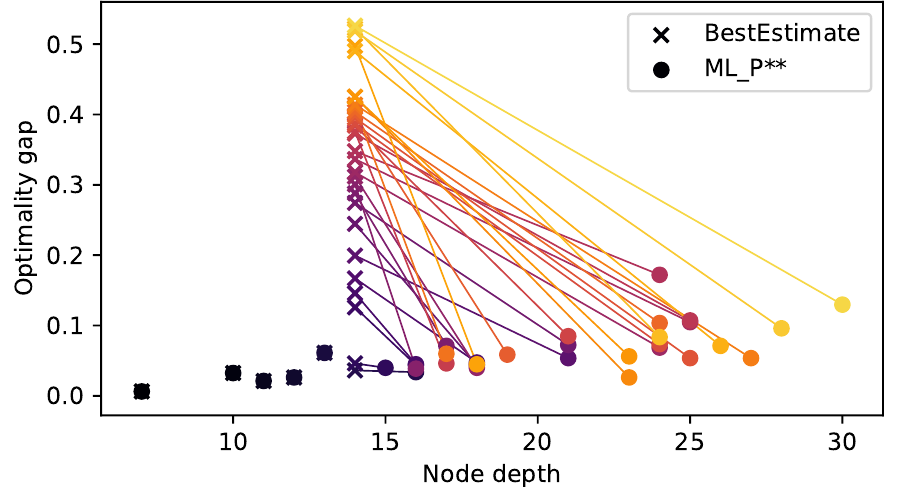
Figure 8. Set cover: node depth vs. optimality gap attained at the final node, after one plunge. Each point-pair corresponds to one instance: one for BestEstimate ( × ) and one for the learned policy ( • ). ‘**’ p <